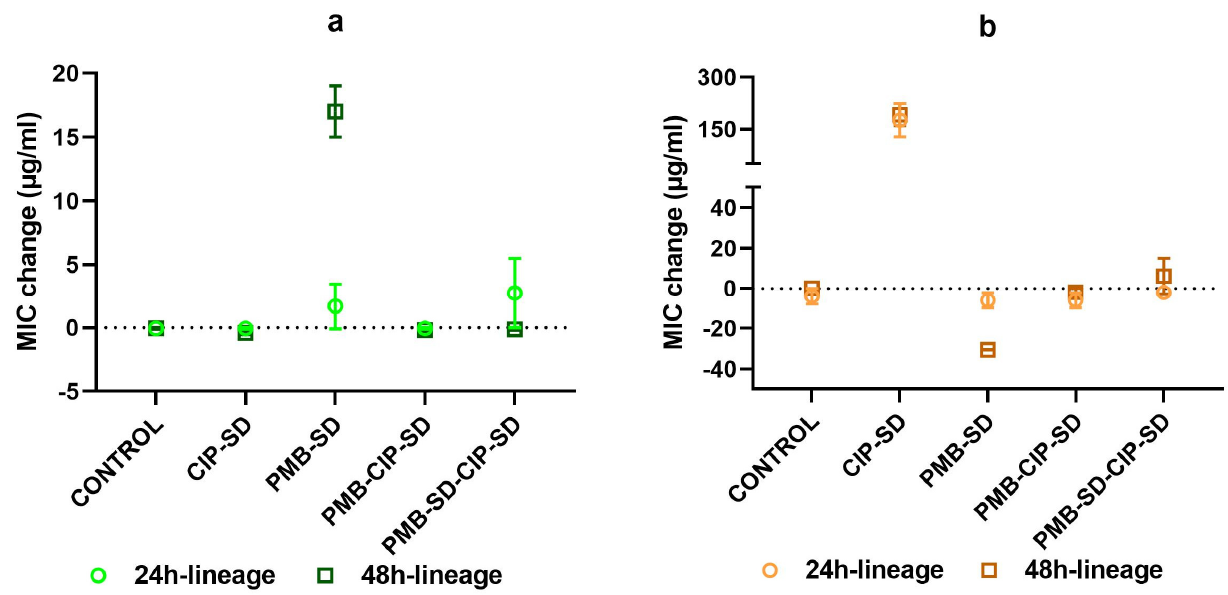
Figure 9. Change in MIC of PMB ( a ) and CIP ( b ) against lineages isolated from time–kill assay (mean ± SEM, n = 4). Lineages are grouped by names in the experimental design of the time–kill assay (Figure 1 and Table 3).